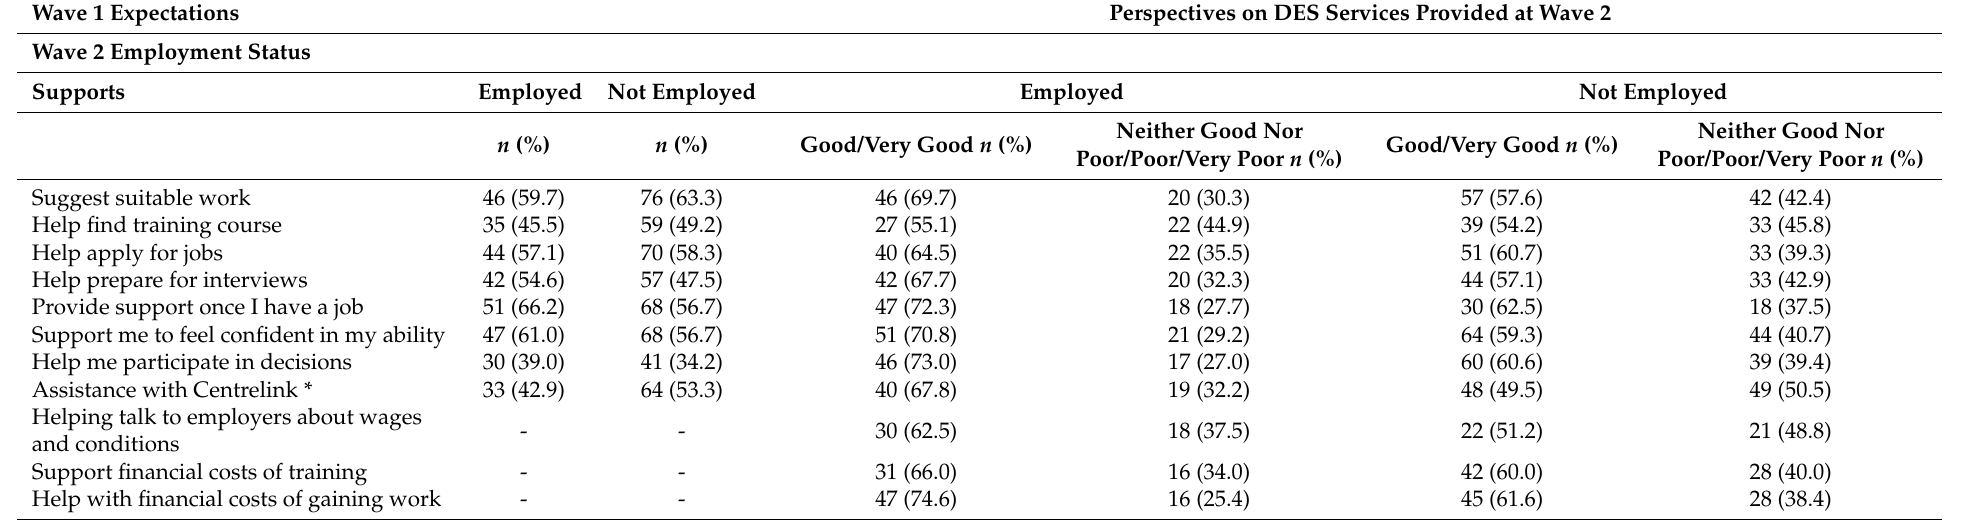
Table 6. Wave 1 expectations of DES supports and Wave 2 perspectives on DES supports provided, by employment